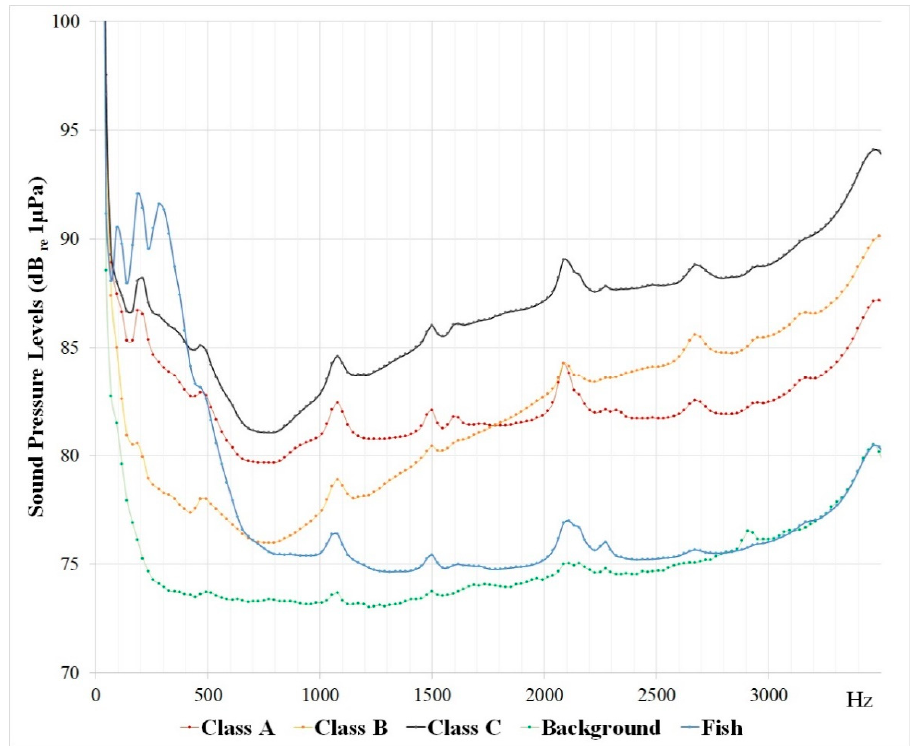
Figure 4. Averaged sound pressure level rms (sampling frequency of 192 kHz; frequency resolution of 23.4 Hz; Hamming window; and FFT size of 8192 points) of all files with Class A (red), Class B (orange), and Class C (dark gray) boat noise, fish chorus (blue), and background noise (green). In order to normalize the data, the black drum call rate parameter was measured, dividing the number of counted calls by the duration in seconds of the analyzed record ‐ ing: 𝑁𝑢𝑚𝑏𝑒𝑟 𝑜𝑓 𝑐𝑎𝑙𝑙𝑠 𝑐𝑜𝑢𝑛𝑡𝑒𝑑 𝑓𝑜𝑟 𝑓𝑖𝑙𝑒 𝐵𝑙𝑎𝑐𝑘 𝑑𝑟𝑢𝑚 𝑐𝑎𝑙𝑙 𝑟𝑎𝑡𝑒 (cid:3404) 𝑑𝑢𝑟𝑎𝑡𝑖𝑜𝑛 (cid:4666)𝑠(cid:4667) 𝑜𝑓 𝑎𝑛𝑎𝑙𝑦𝑠𝑒𝑑 𝑟𝑒𝑐𝑜𝑟𝑑𝑖𝑛𝑔